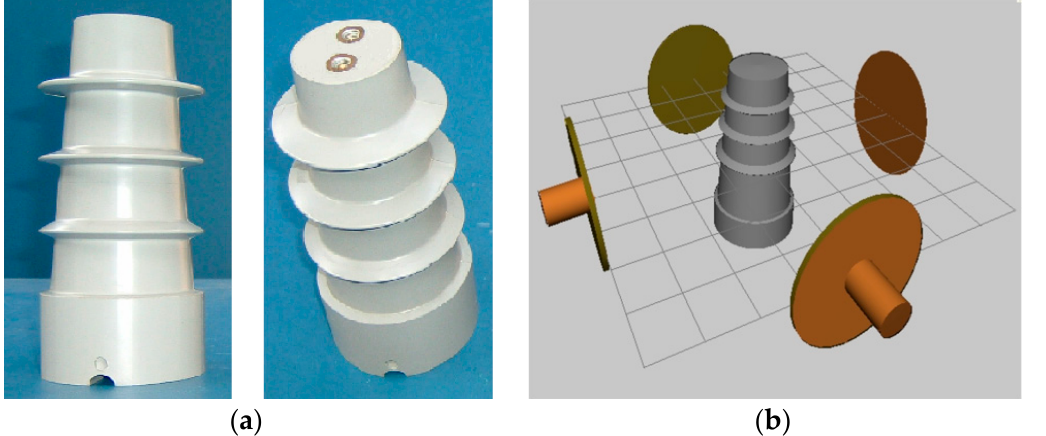
Figure 10. ( a ) General view of the test object and ( b ) location of two pairs of probes in relation to the object containing the defect.